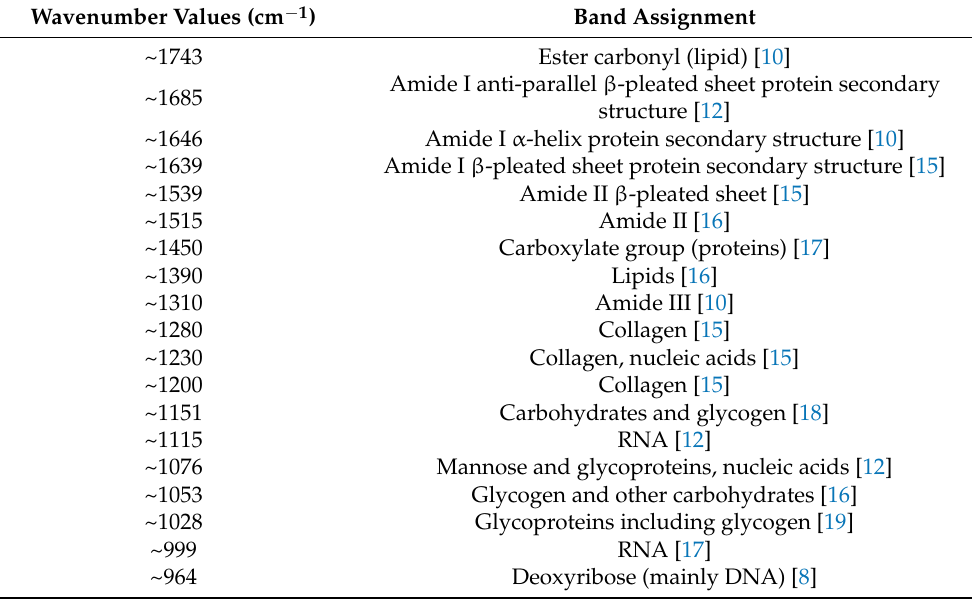
Table 1. Infra-red band assignments for intestinal tissue. Wavenumber Values (cm − 1